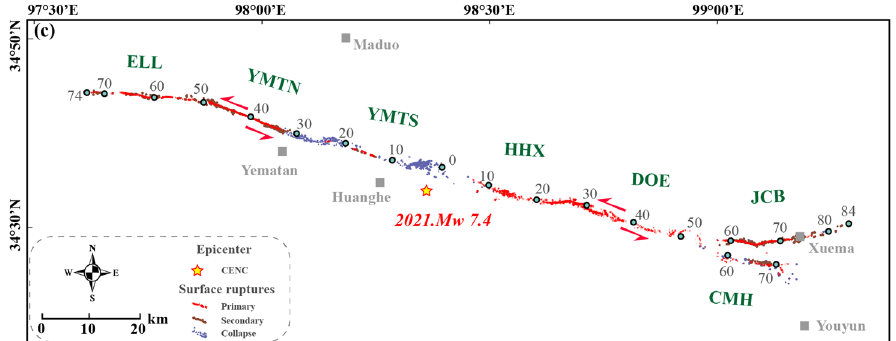
Figure 1. ( a ) Active tectonics and historical earthquakes (in the past 25 years) around the Bayan Har Block. Fault data are modified by Tapponnier et al. [28], Rui et al. [29] and Burchfiel et al. [30]. Mw ≥ 6.5 earthquakes that have occurred at the boundary of the Bayan Har Block since the turn of the century include: the 2001 Mw 7.8 Kokoxili earthquake [31], the 2008 Mw 7.9 Wenchuan earthquake [32], the 2010 Mw 6.9 Yushu earthquake [33], the 2013 Mw 6.6 Lushan earthquake [34], the 2008 Mw 7.0 and 2014 Mw 7.2 Yutian earthquake [35,36], and the 2017 Mw 6.5 Jiuzhaigou earthquake [37]. Abbreviations for active faults: ATF, Altyn Tagh fault; QLHYF, Qilian-haiyuan fault; KLF, Kunlun fault; LMSF, Longmenshan fault; XSHF, Xianshuihe fault; JLF, Jiali fault; KKF, Karakoram fault. Small red box is location of Figure 1b. ( b ) Geologic and tectonic setting of the 2021 Mw 7.4 Maduo earthquake. Geological data are from the public geological map (1:500,000). Active faults adapted from Tapponnier et al. [38], Pan et al. [2] and Ren et al. [39]. Seismic data are from China Earthquake Networks Center (https://www.cea-igp.ac.cn/kydt/278249.html, accessed on 22 May 2021). Small orange boxs are location of Figure 9. ( c ) Coseismic surface ruptures of the 2021 Mw 7.4 Maduo earthquake. Databases are obtained from post-earthquake identification and mapping based on the UAV photogrammetry technology (modified by Liu-Zeng et al. [1]).